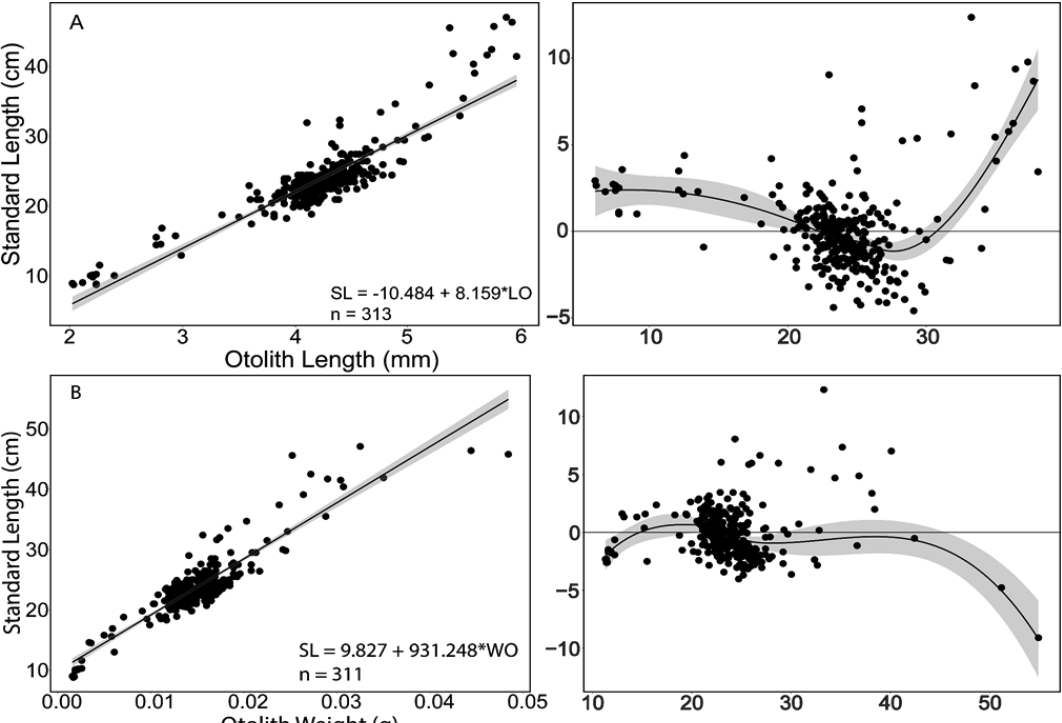
Fig. 3. Fits of the linear regressions between lapillus otolith and standard length of Prochilodus lineatus : a . Otolith Length (r 2 = 0.80) and b. Otolith Weight (r 2 = 0.82); the shaded area represents the confidence interval of 95% of the estimate; loess fit of raw residuals are in right panels.